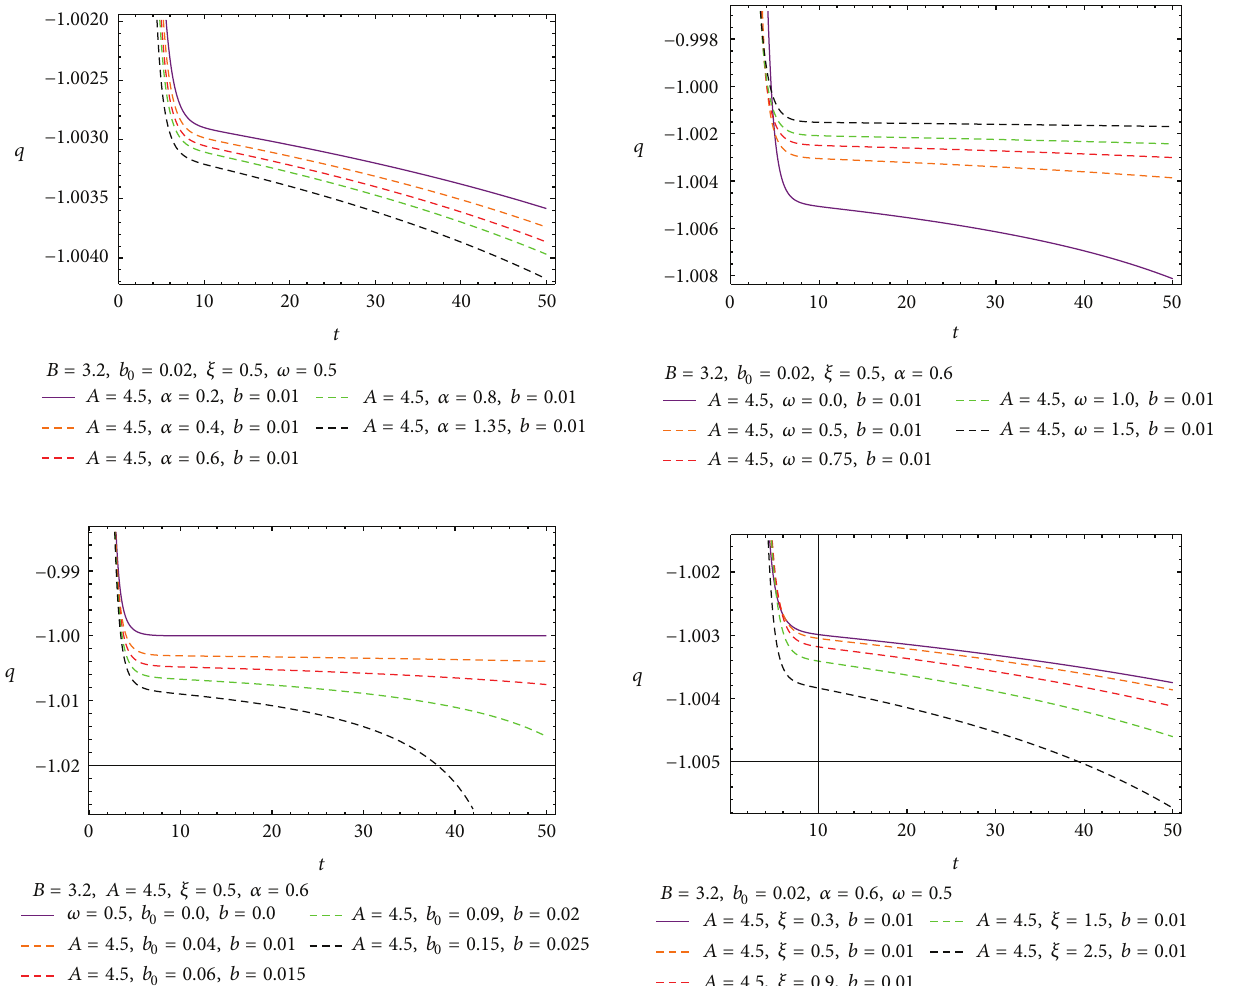
Figure 3: Behavior of deceleration parameter 𝑞 against 𝑡 for interacting barotropic fluid and viscous modified Chaplygin